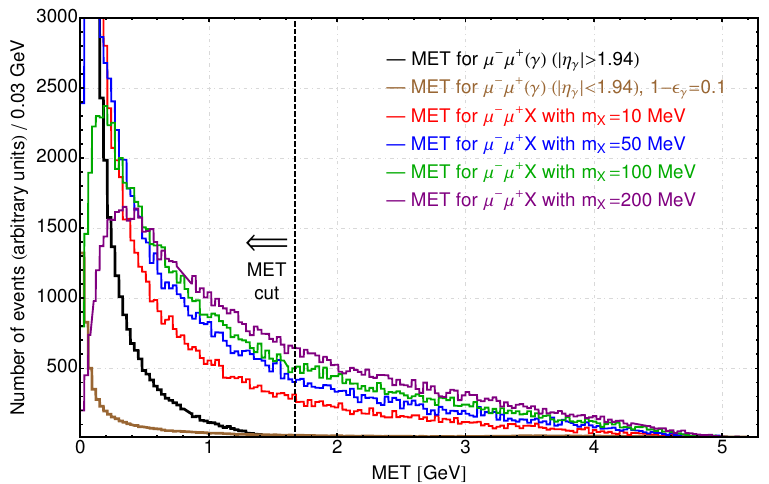
Figure 6 . =E distribution for (cid:22) (cid:0) (cid:22) + (cid:13) backgrounds and (cid:22) (cid:0) (cid:22) + X signal events. We only choose T events with =E > 1 : 67 GeV. We show (cid:22) (cid:0) (cid:22) + + unobserved (cid:13) ( T photon detection ine(cid:14)ciency 1 (cid:15) (cid:13) = 10 (cid:0) 1 for demonstration. The =E (cid:0) dotted line. Each event set contains 1 10 5 events. (cid:2)